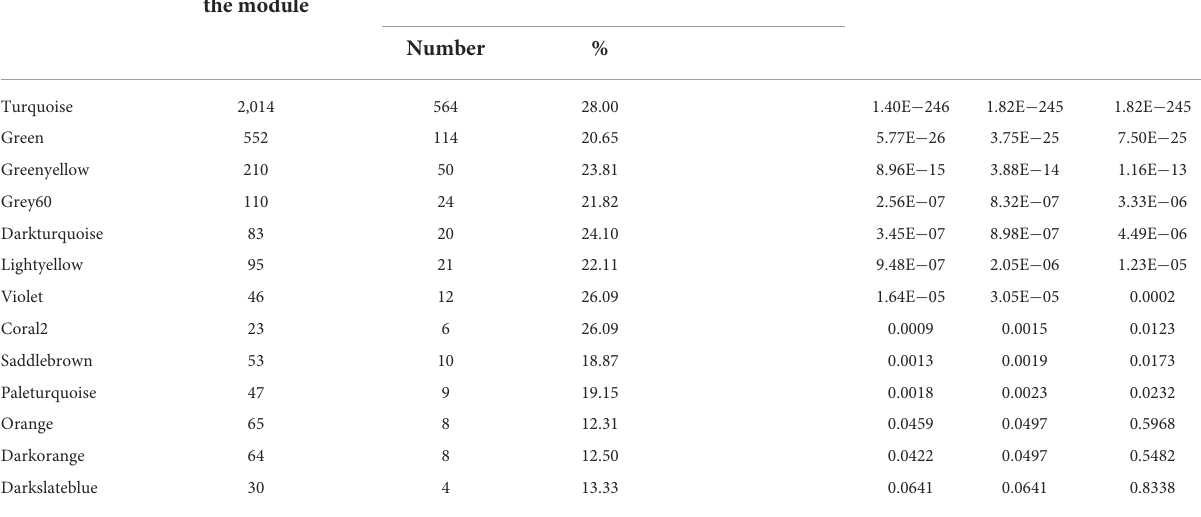
TABLE 1 Results from the overrepresentation analyses among genes in modules significantly correlated to milk fat phenotypes and the milk fat gene list a